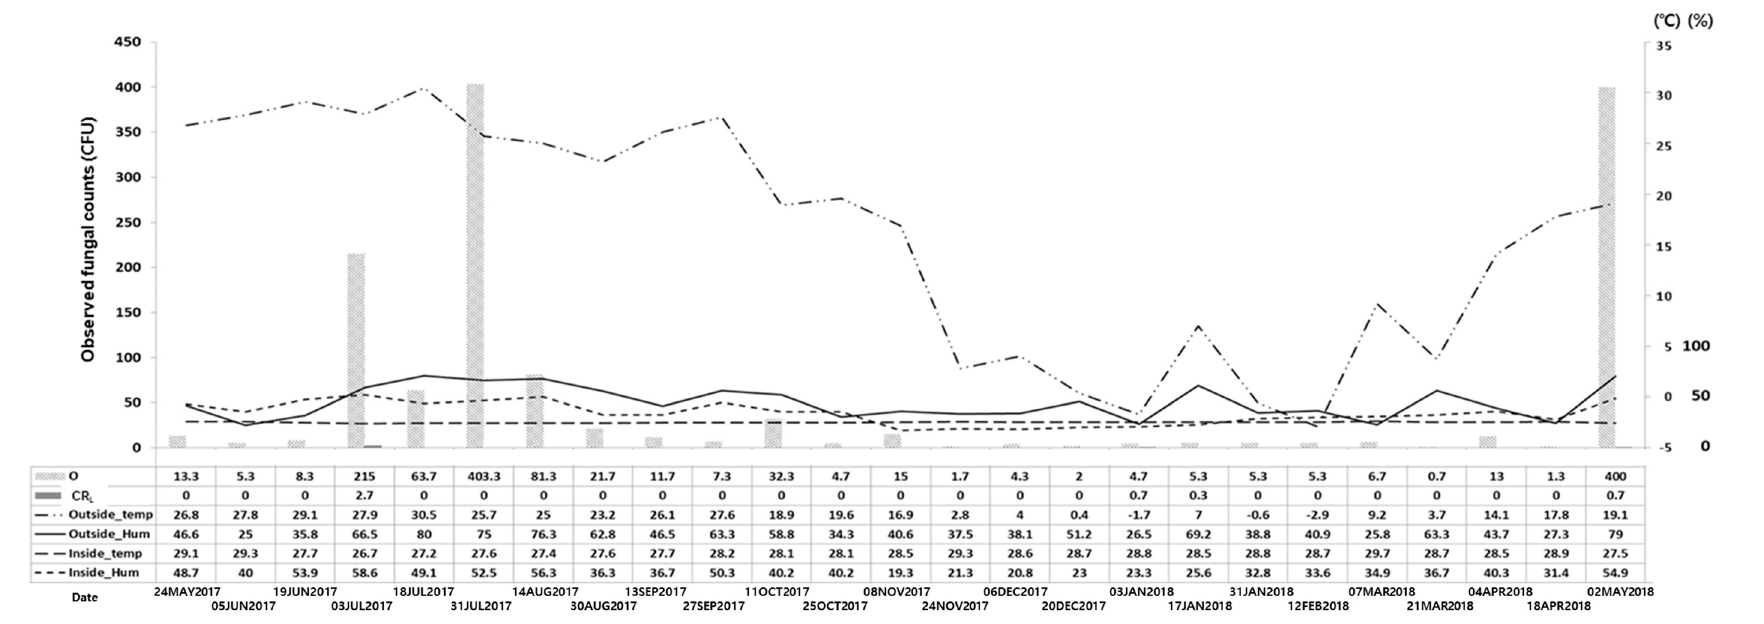
Figure 1. Trends in fungal density according to temperature and relative humidity. Abbreviations: CFU, colony-forming unit; CR L , lounge of the cleanroom; Hum, relative humidity; O, outside the hospital; Temp, temperature.